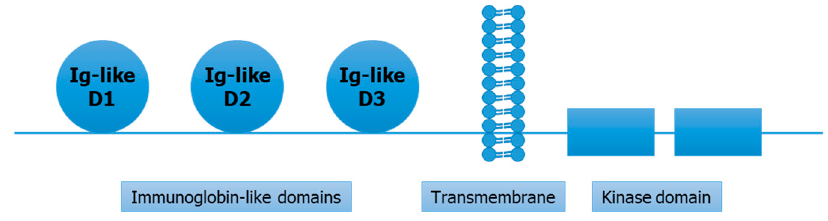
Figure 1. Structural overview of fibroblast growth factor receptor 4 ( FGFR4 ) protein.